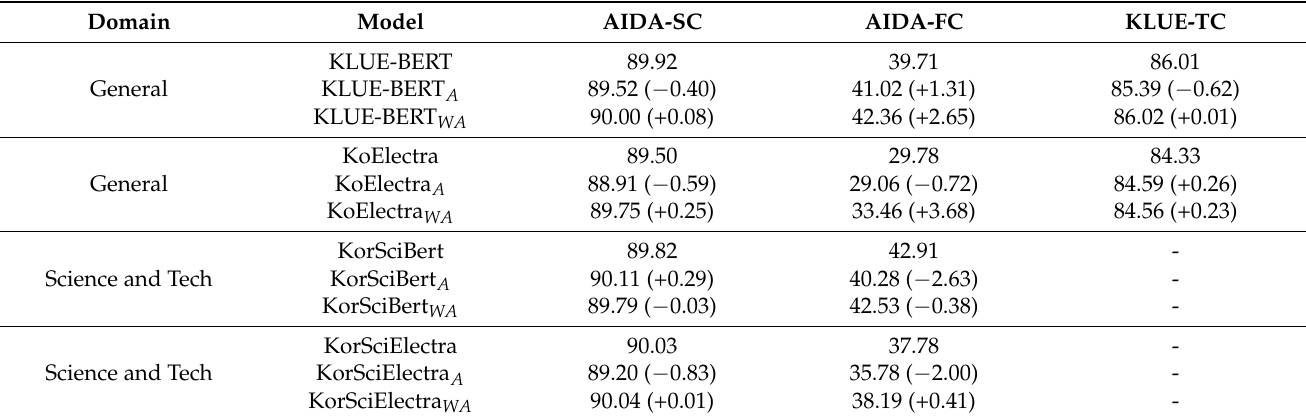
Table 3. Result of different pre-trained models with or without extended vocabulary. A is a model with extension vocabulary. WA is a model with extension vocabulary and curriculum learning.